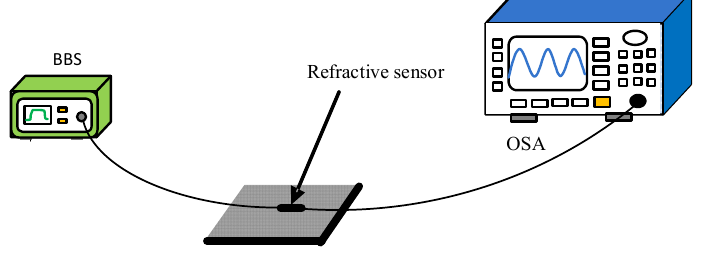
Figure 11. Refractive index sensing experimental device schematic diagram.